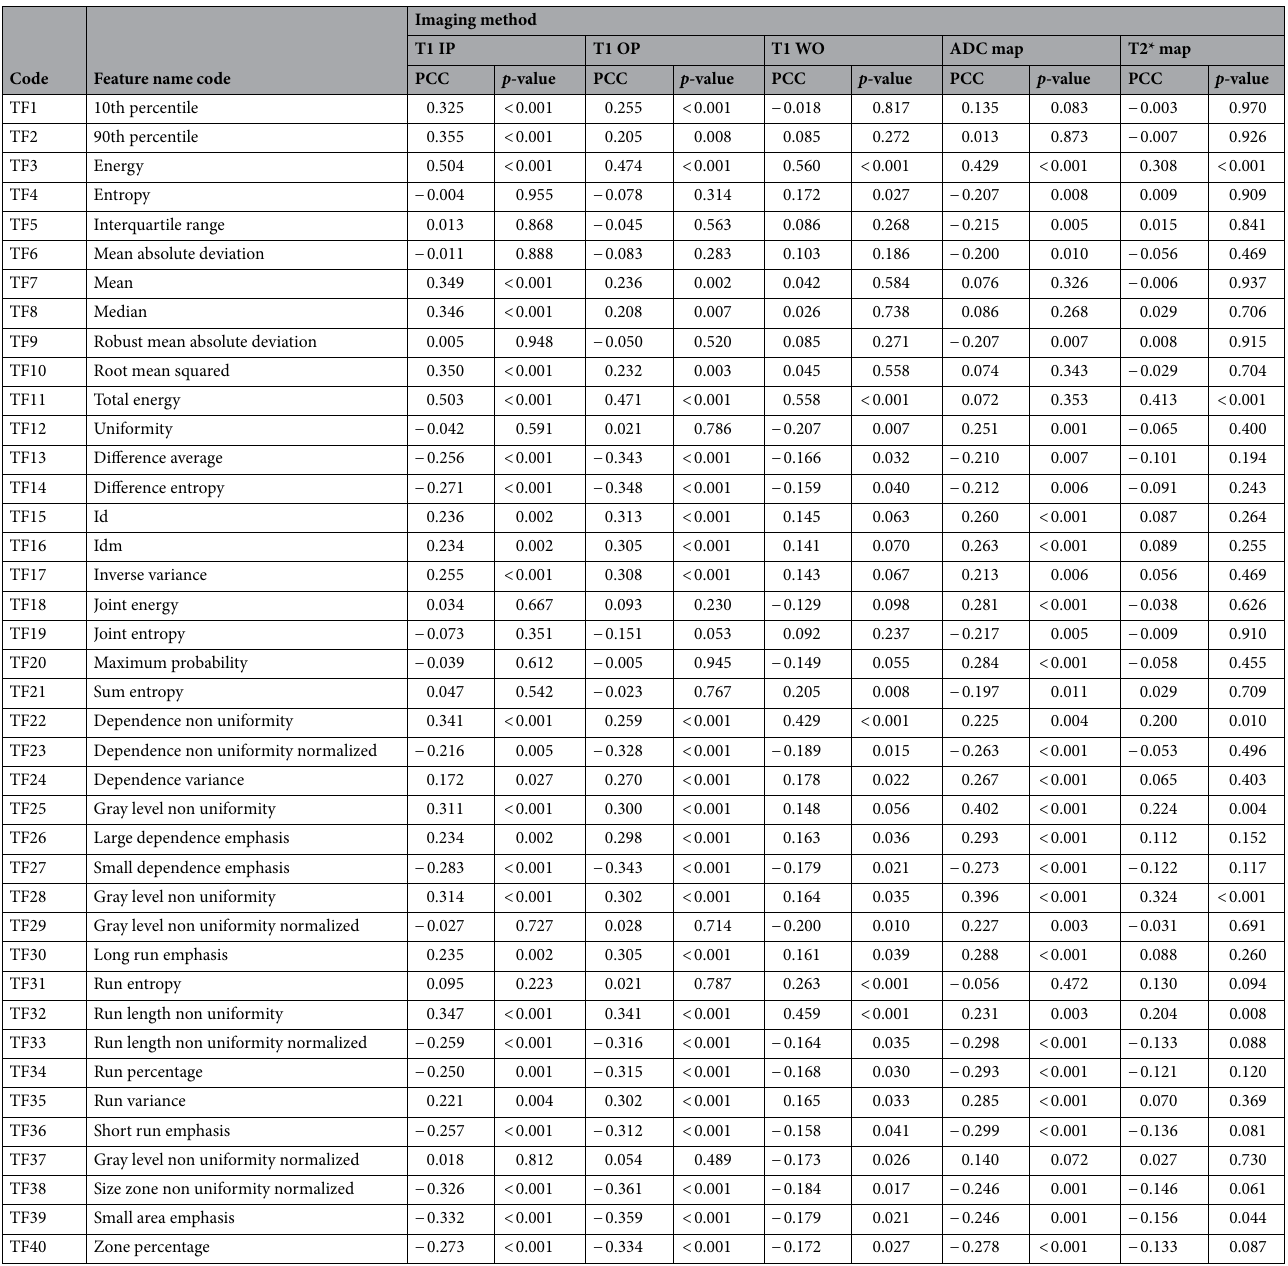
Table 8. The cross-correlation analyses between the eGFR and the 40 texture features derived from each imaging method. ADC apparent diffusion coefficient, eGFR estimated glomerular filtration rate, GLCM gray-level co-occurrence matrix, GLDM gray-level dependence matrix, GLRLM gray-level run length matrix, GLSZM gray-level size zone matrix, IP in-phase, OP opposed-phase, PCC Pearson’s Correlation Coefficient, TF texture feature, WO